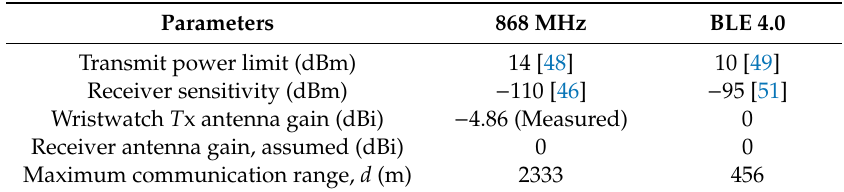
Table 1. Parameters for calculating the communication range at 868 MHz and BLE